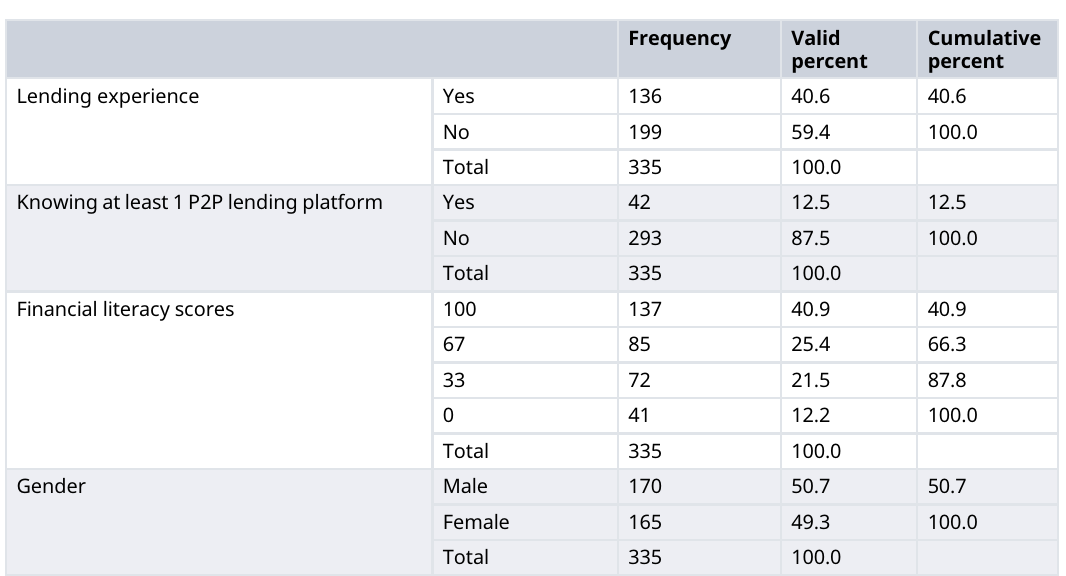
Table 3. Frequencies.